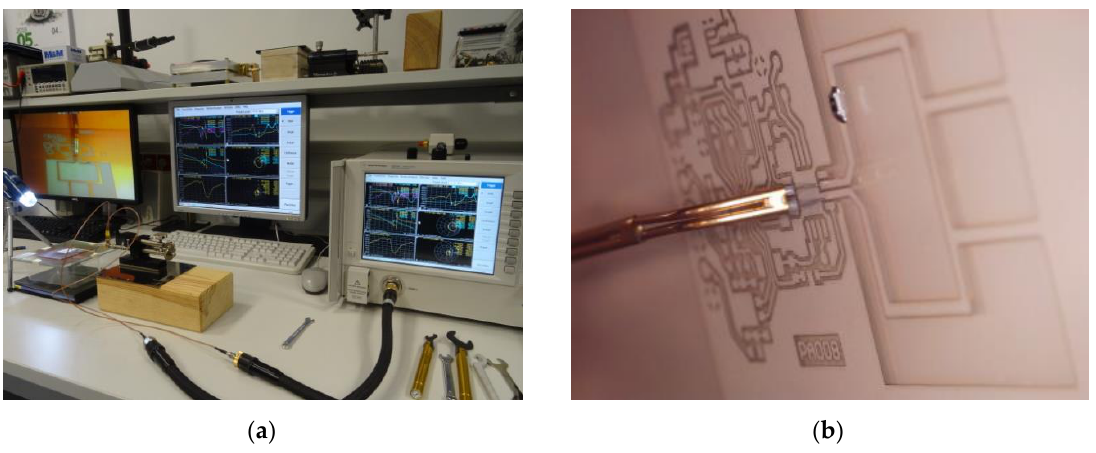
Laboratory site: ( a ) measurement stand for impedance parameter determination; ( b ) di ff erential probe with sharp tips.